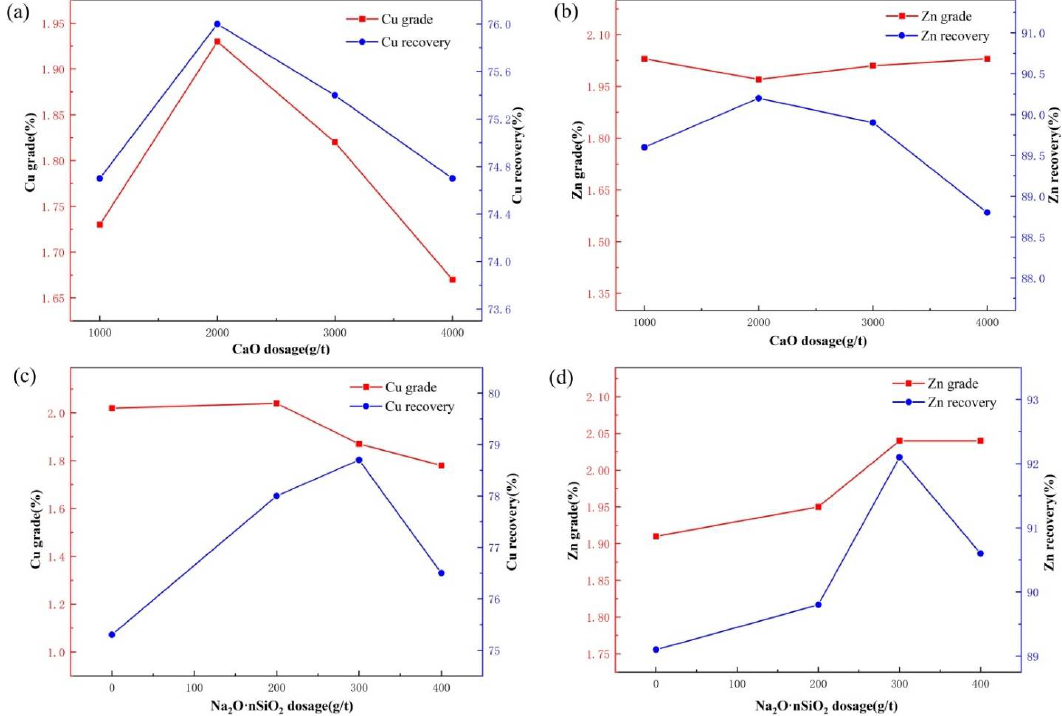
Figure 10. Effects of CaO ( a , b ) and Na 2 O nSiO 2 ( c , d ) dosages on rough copper flotation.